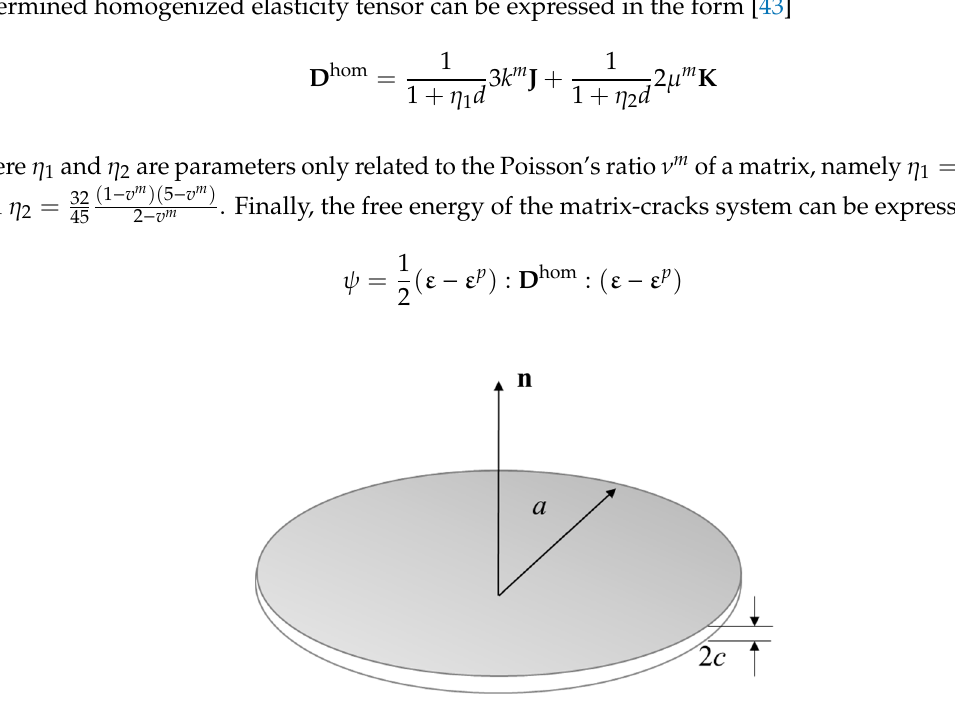
Figure 10. Schematic representation of a penny-shaped crack.